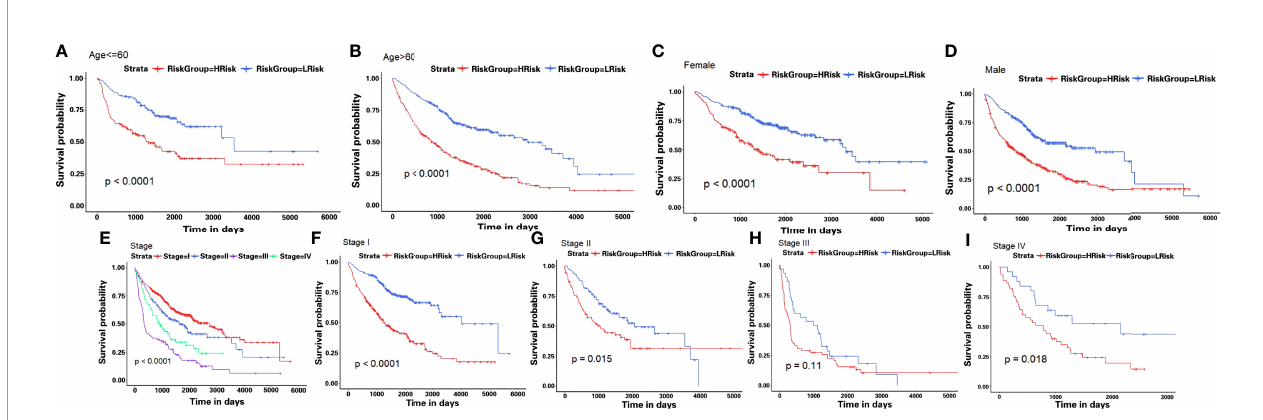
FIGURE 7 | Kaplan – Meier survival analyses of the HAGS risk score in different subgroups. (A – I) LUAD patients in the low-risk group showed a more promising OS than the high-risk group in all subgroups ( p <